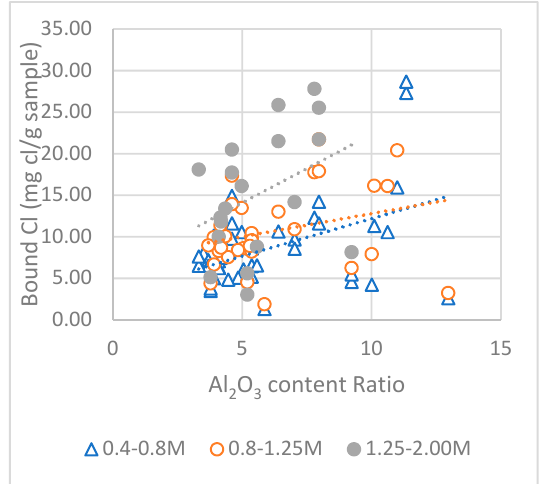
Figure 11. Relation between Al 2 O 3 ratio and bound chloride for different chloride concentrations for all data.